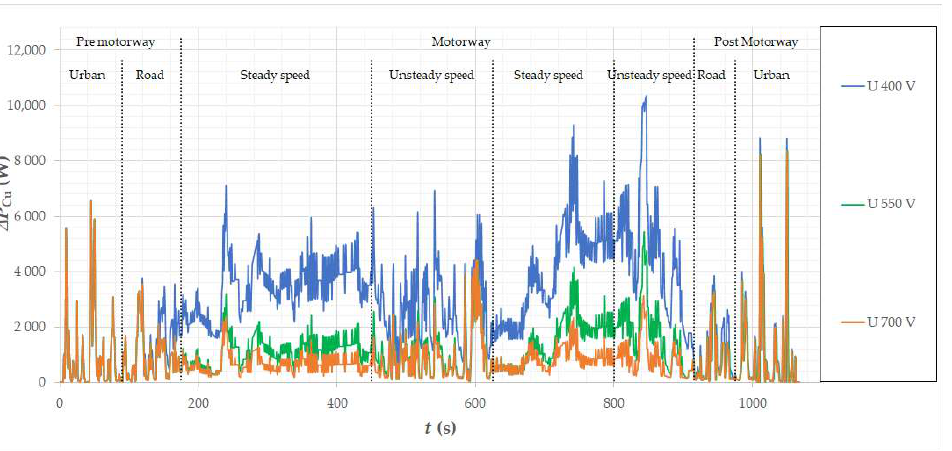
Figure 33. Calculated loss waveforms in motor windings for the considered vehicle in the Artemis Motorway150 cycle .